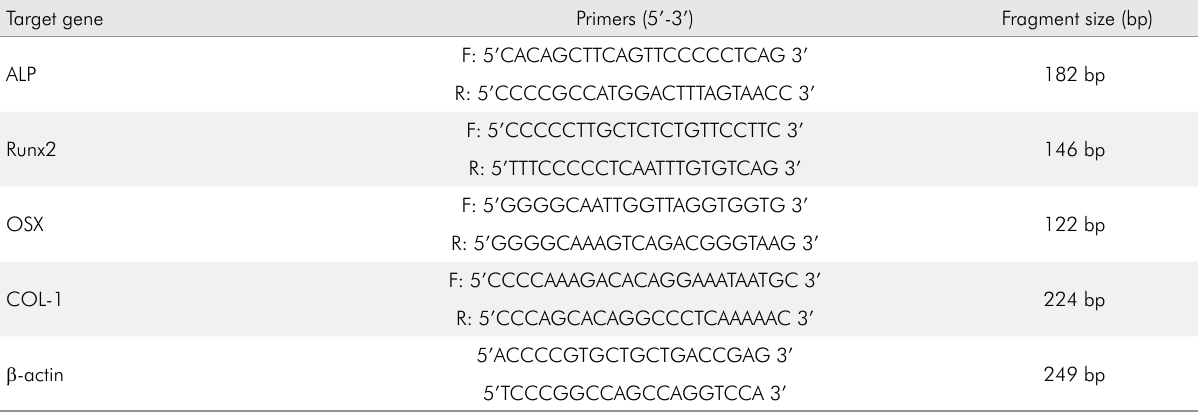
Table 1. Primer sequences used for quantitative real-time polymerase chain reaction. Target